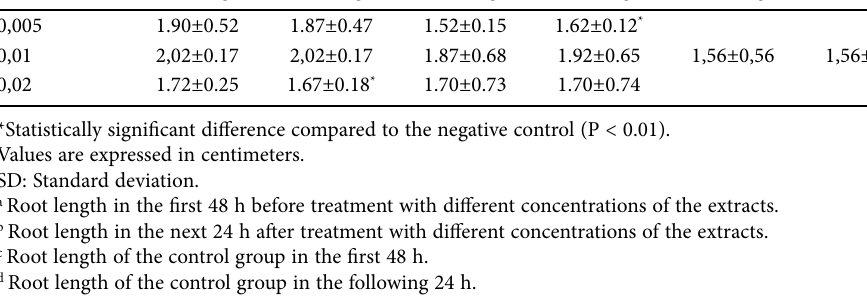
Table 1 Roots length of Allium cepa (mean ± SD) before and after the treatment with different concentrations of the tested P. major extracts. Concentration (mg/ml)